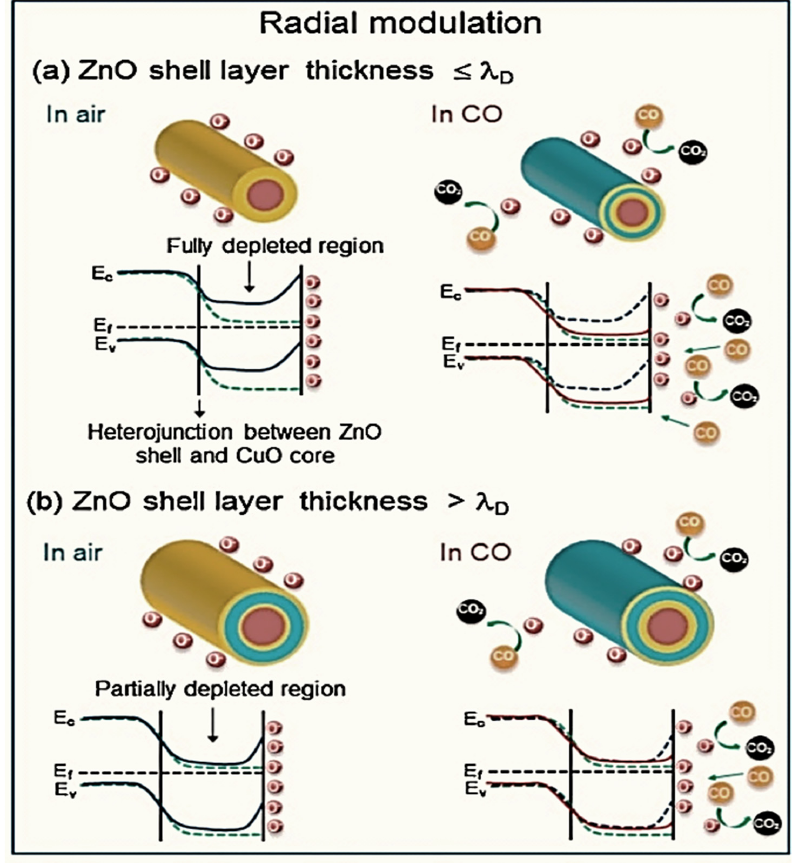
Figure 4. Schematic of the reducing gas-sensing mechanism of the CuO–ZnO C–S NW sensor for ZnO shell layers with thicknesses ( a ) less than λ D and ( b ) greater than λ D . Reproduced from [74] with the permission of Elsevier.